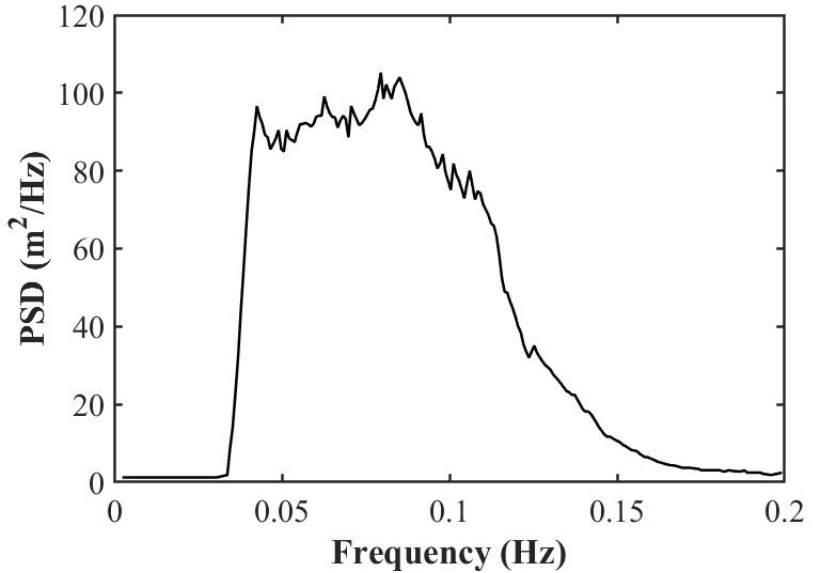
Figure 10. Irregular wave spectrum.